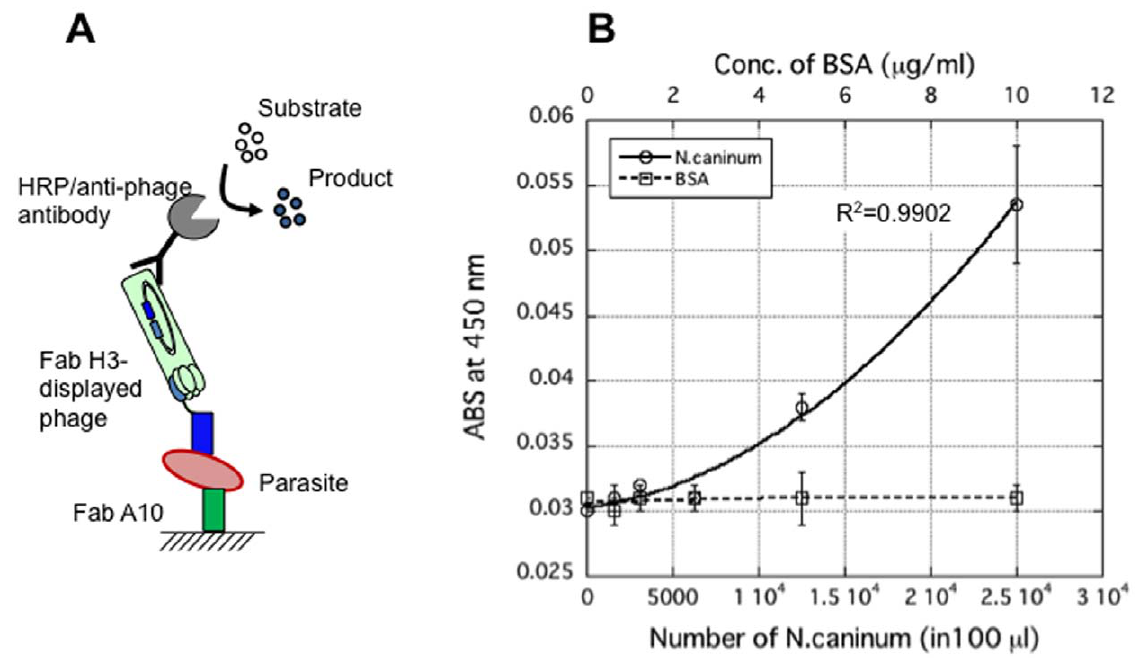
Figure 6. Inhibition of A10 (A) and H3 (B) antibody binding to rNcSAG1 with anti- N.caninum antibodies in neosporosis-positive serum. Sera samples from healthy cattle (negative) and that from cattle with neosporosis (positive) were used to inhibit the binding of A10 or H3 to immobilized rNcSAG1on a microplate (n=3).